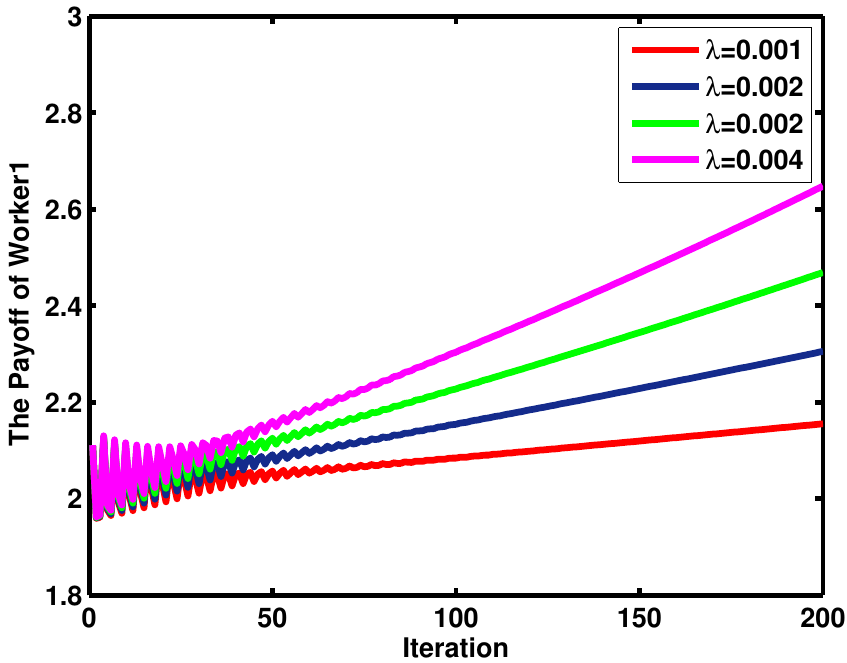
Figure 9. The payoff of worker 1 using ZD3 strategies with different λ .